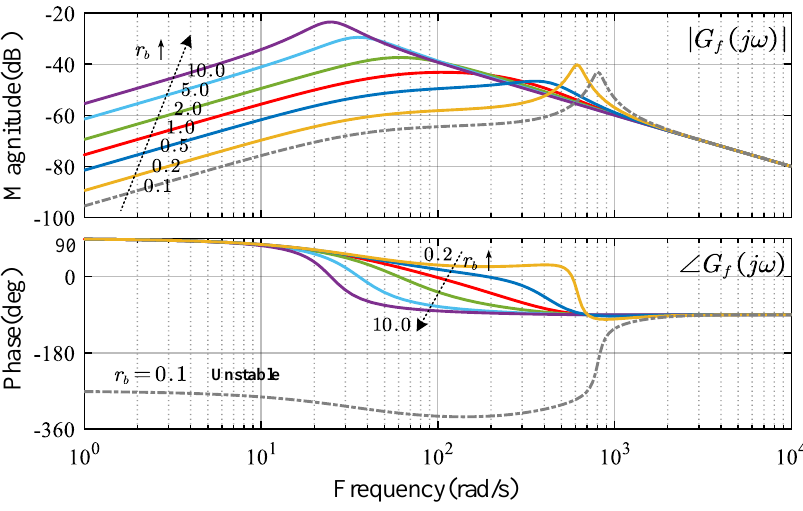
Figure 7. Bode diagram of G f ( s ) under different r b